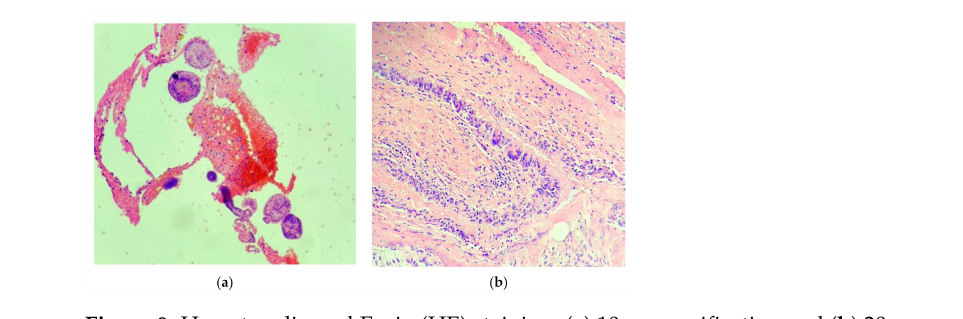
Figure 9. Hematoxylin and Eosin (HE) staining: ( a ) 10 × magnification and ( b ) 20 × magnification.